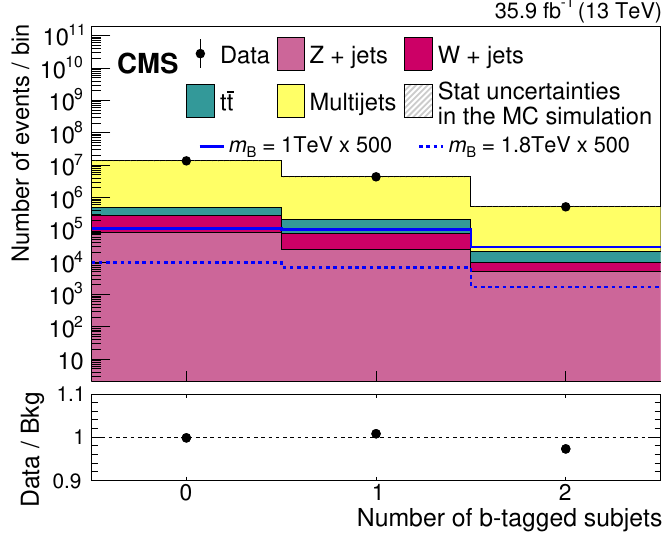
Figure 2. The b-tagged subjet multiplicity of AK8 jets in events passing preselection criteria. The lower panel shows the ratio of data to the MC background prediction. The normalization of the contributions from signals at m B = 1 and 1.8 TeV is multiplied by a factor of 500. Background events are normalized to data. Only the statistical uncertainties are taken into consideration here, and they are too small to be